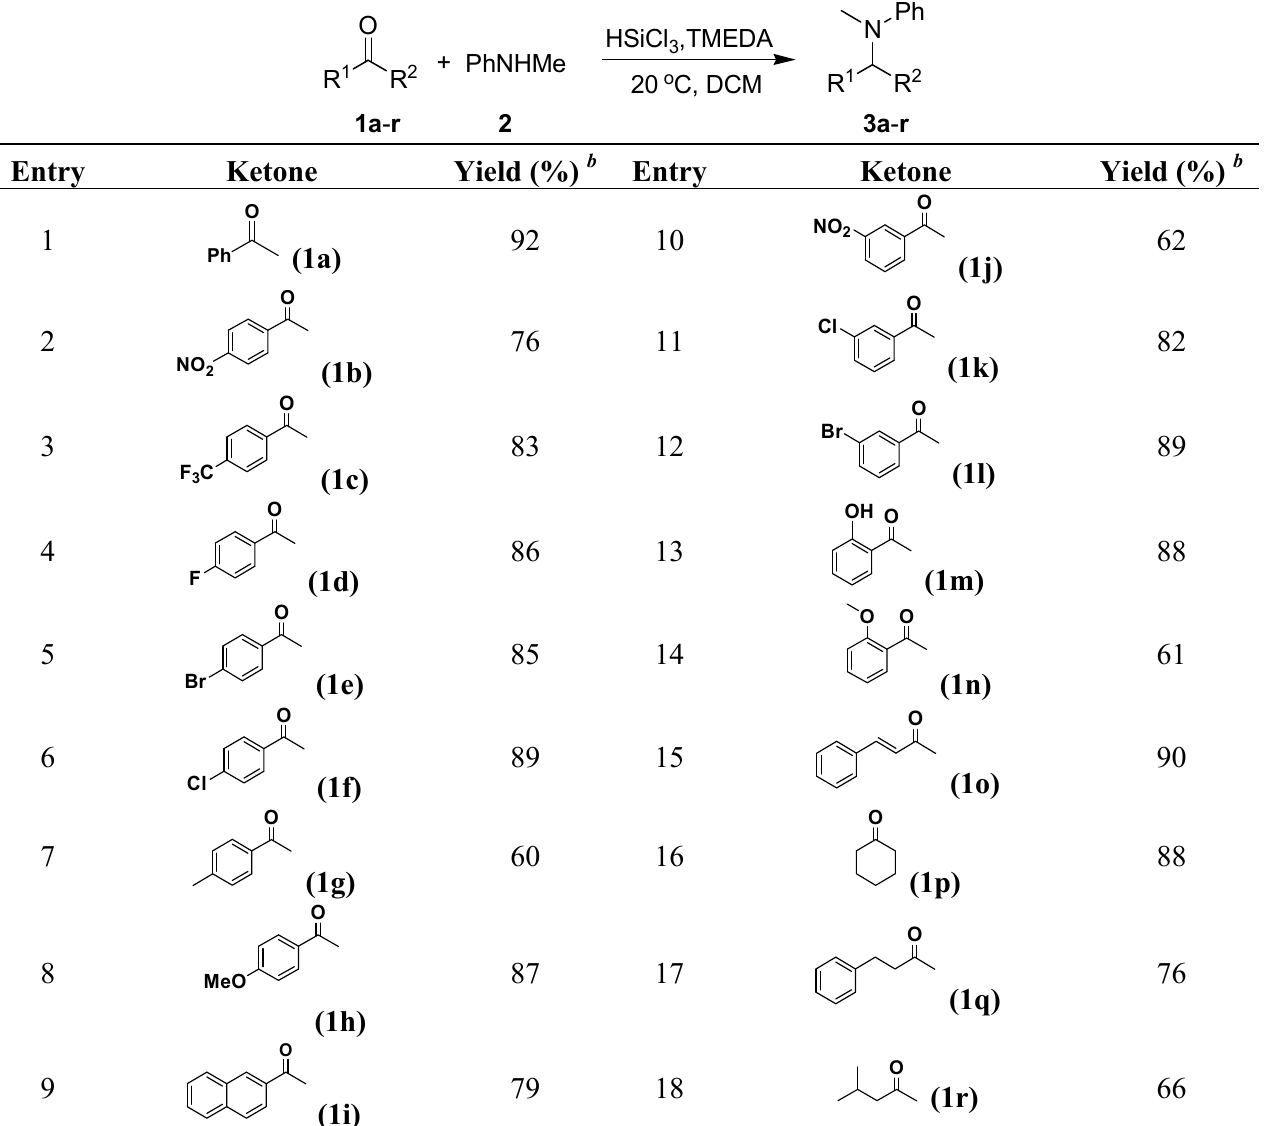
Table 2. Direct reductive amination of various acetophenone analogues with N -methylaniline a .